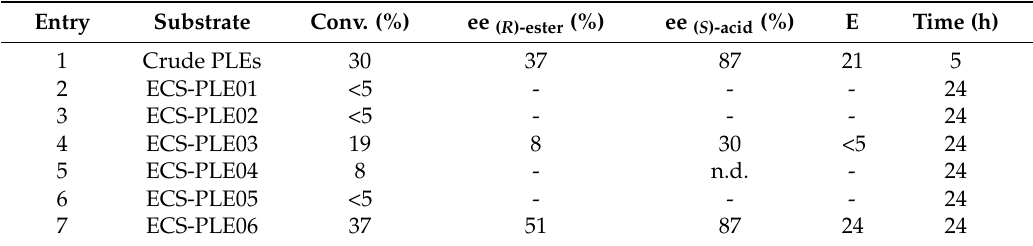
Table 2. Hydrolysis of 1e with PLE; conditions: [S] = 2.5 mM, [PLE] 7.5 mg/mL in 100 mM phosphate buffer at pH = 7.0 and DMSO (5%), 30 °C.